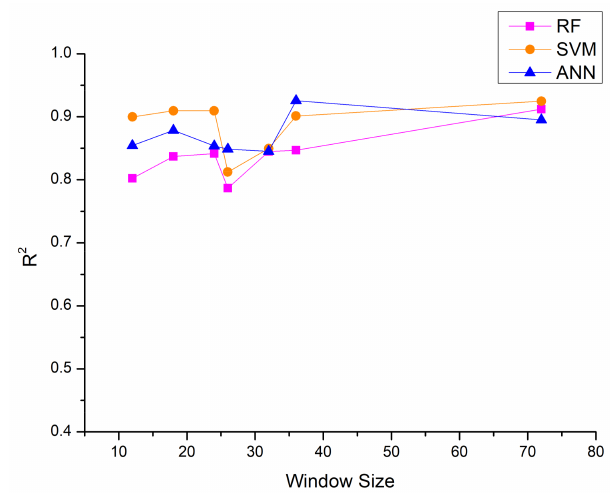
Figure 8. Performance evaluation on different window sizes for prediction.